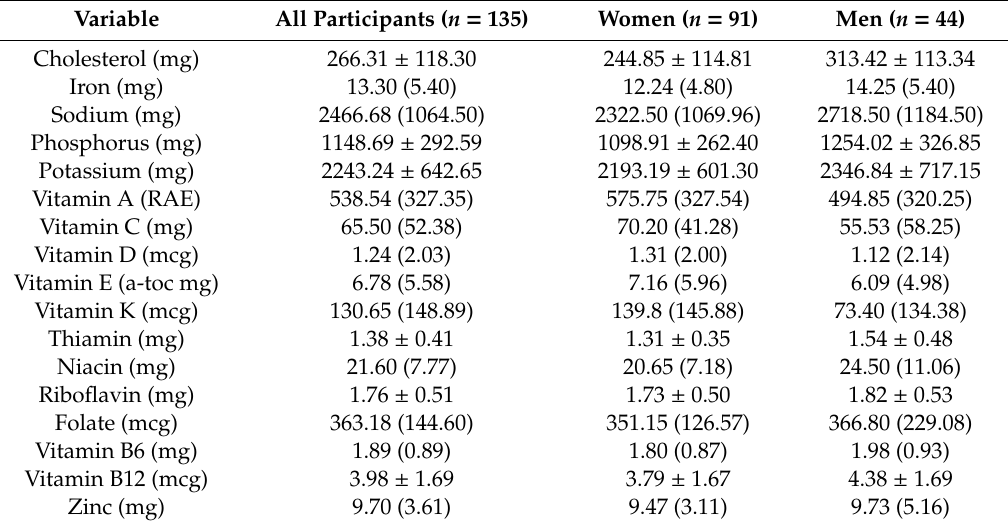
Table 3. Micronutrient intake from the 14-day food diary.